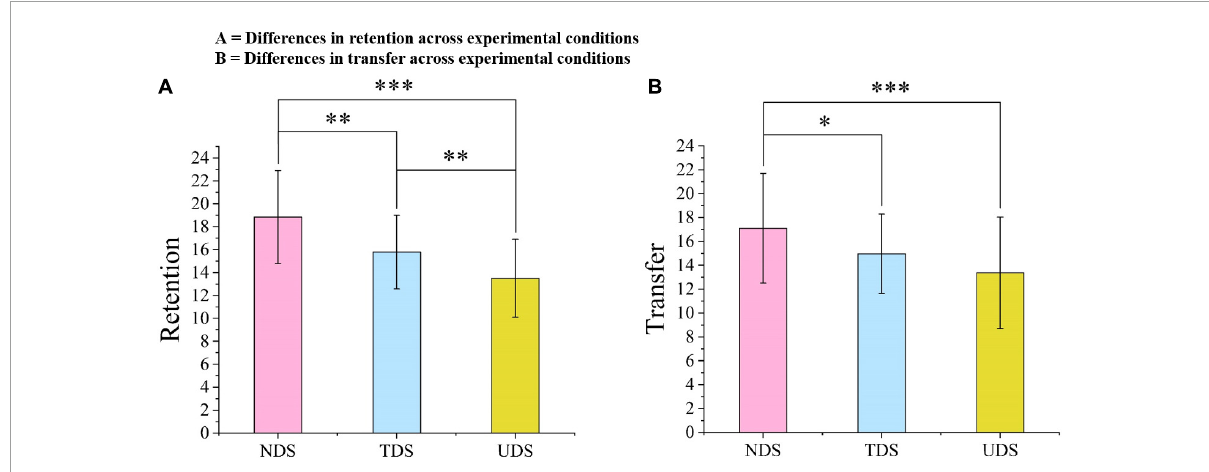
FIGURE4 Differences in retention and transfer across experimental conditions. (A) Differences in retention across experimental conditions and (B) differences in transfer across experimental conditions. ∗ p < 0.05, ∗∗ p < 0.001, ∗∗∗ p <